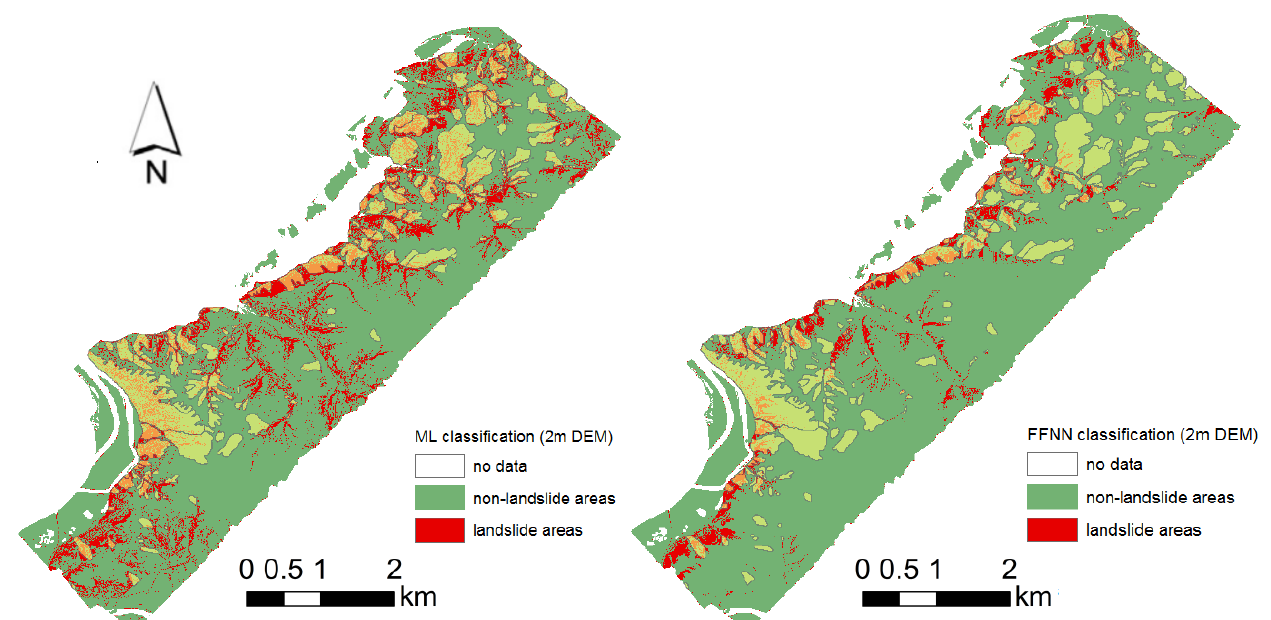
Figure 5 Examples of classification results for 2m resolution of